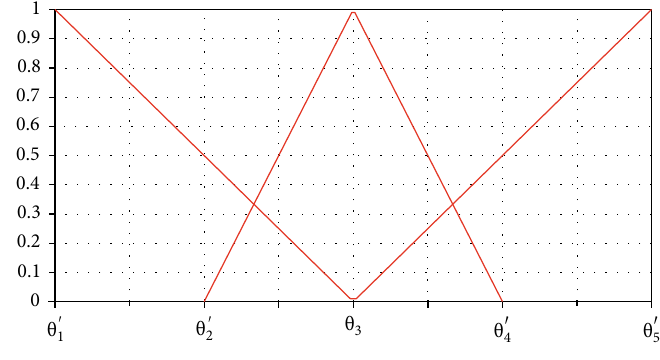
Figure 2: The fi gure of ð ϑ